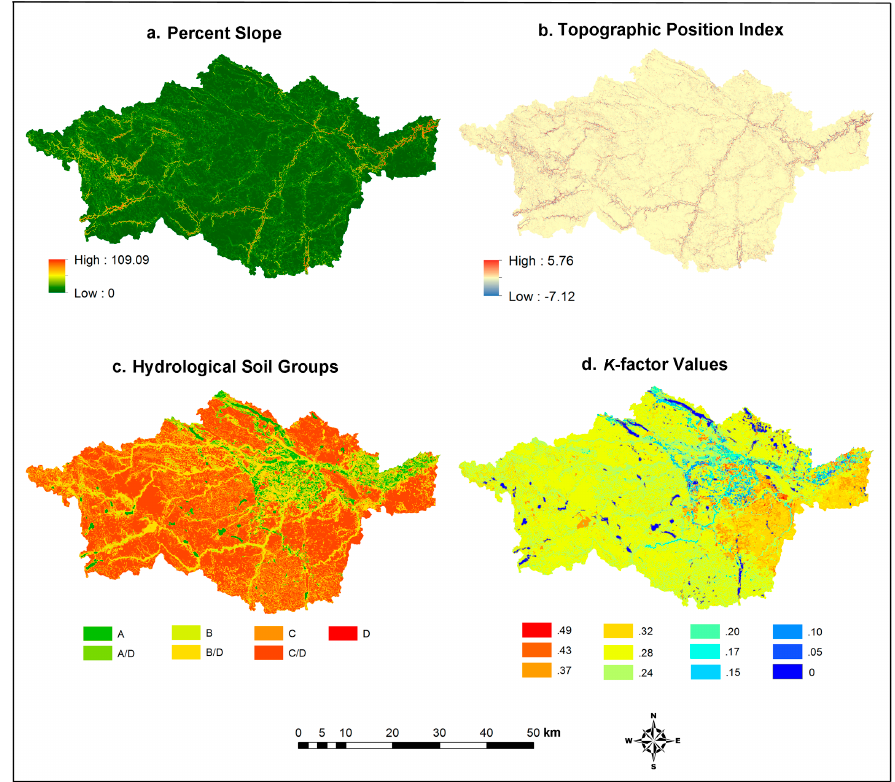
Figure 3. Percent slope and topographic position index derived from the 8.5 m digital elevation model (DEM) and hydrological soil groups and soil erodibility ( K ) factor values for the watershed.